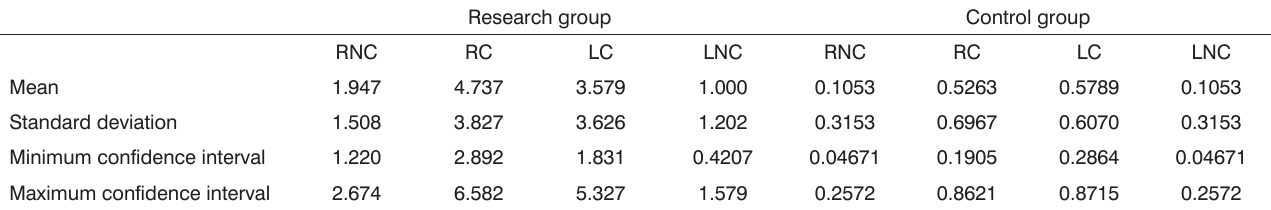
Table 1. Statistical analysis for research and control groups